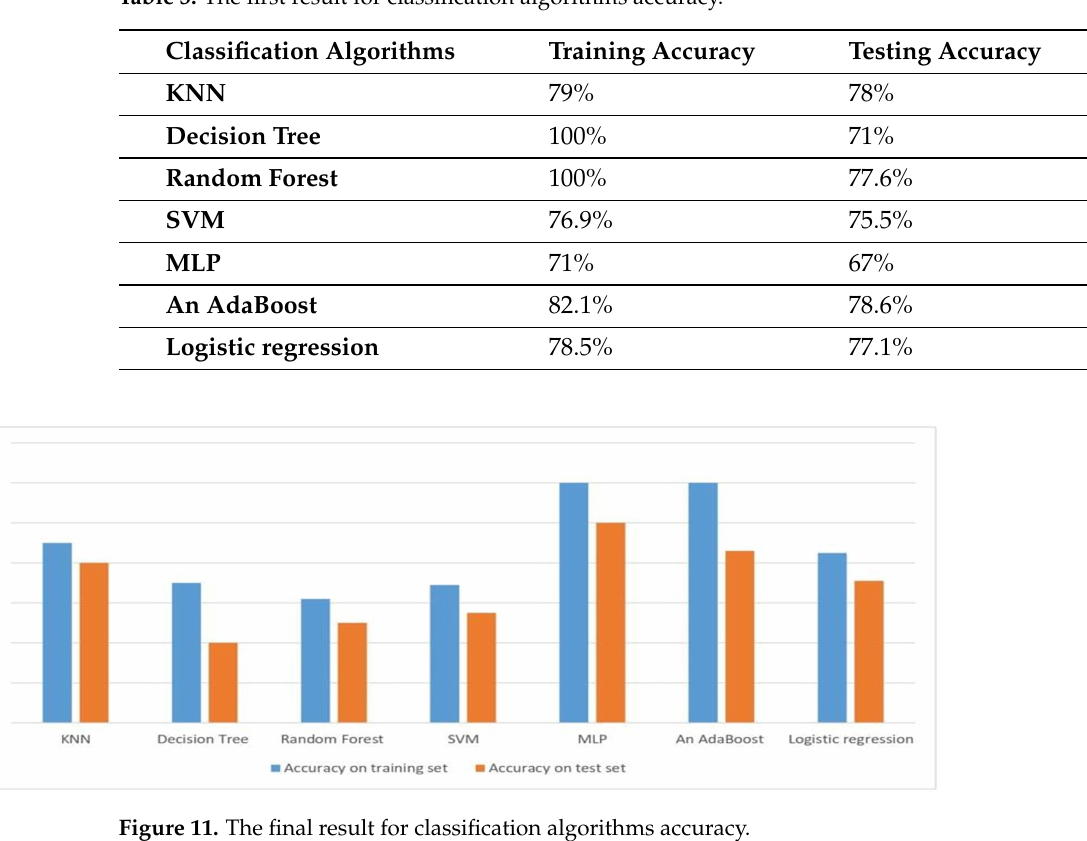
Table 3. The first result for classification algorithms accuracy.